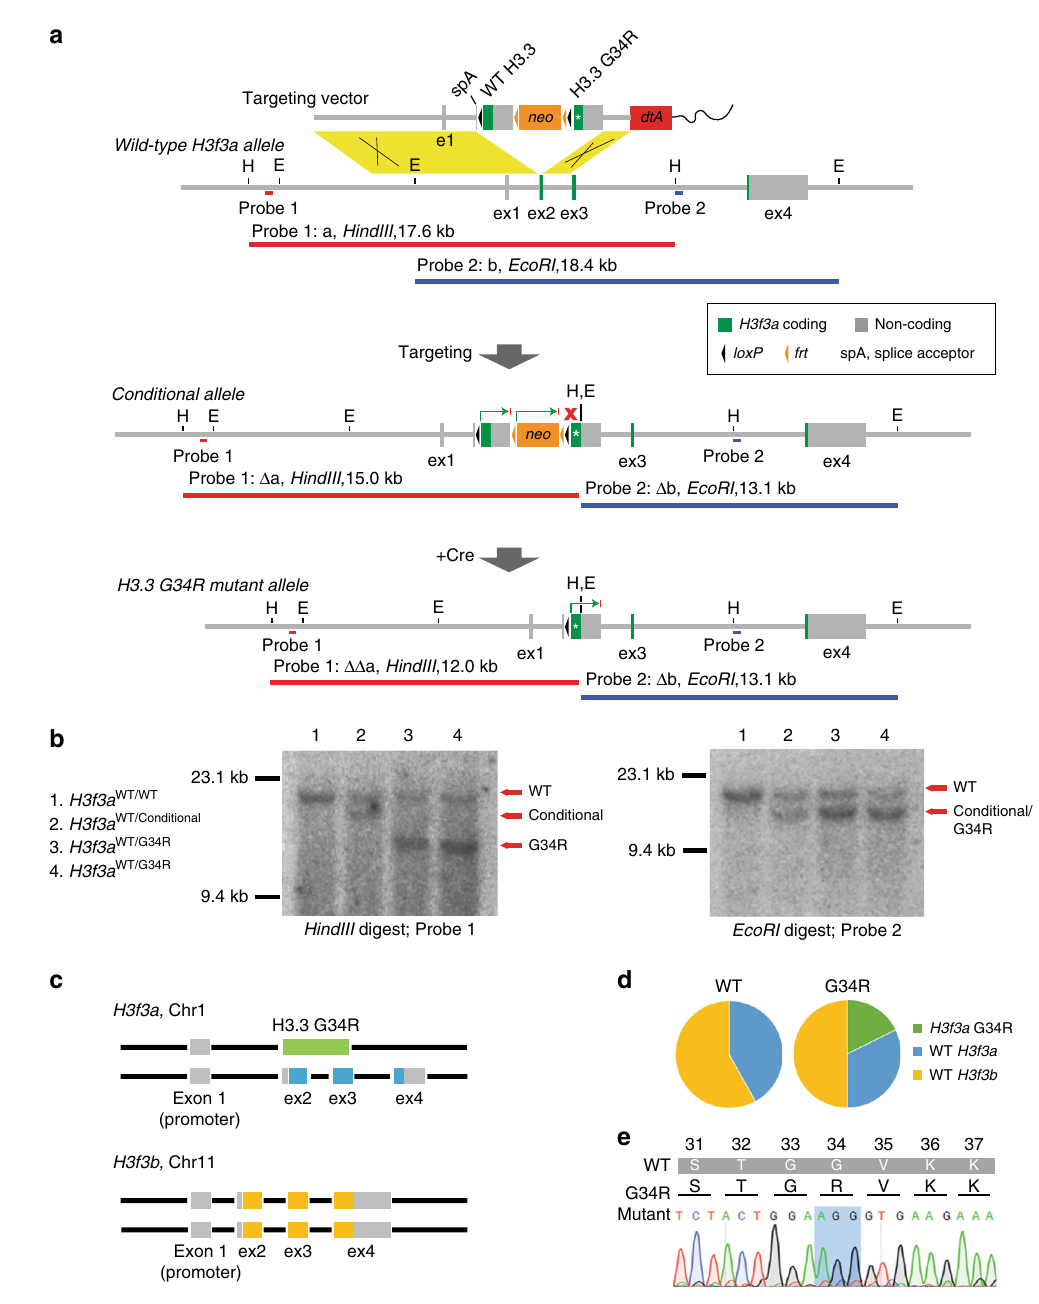
Fig. 1 Creation and characterisation of mouse ES cells with a single copy H3.3 G34R mutation. a Targeting strategy for the expression of an H3.3 G34R mutant transgene from the endogenous H3f3a promoter. Location of Southern blot probes and expected band sizes are shown. b Southern blots of clones which are homozygous for WT H3f3a ; heterozygous for the conditional allele; and heterozygous for the H3.3 G34R mutant allele. c Schematic representation of H3.3 genes in G34R mutants which are heterozygous WT/G34R H3f3a and homozygous for WT H3f3b . d Proportion of RNA-seq reads from WT and G34R cells which map to H3f3a G34R, WT H3f3a and WT H3f3b . e Sanger sequencing of cDNA from G34R cells ampli fi ed with